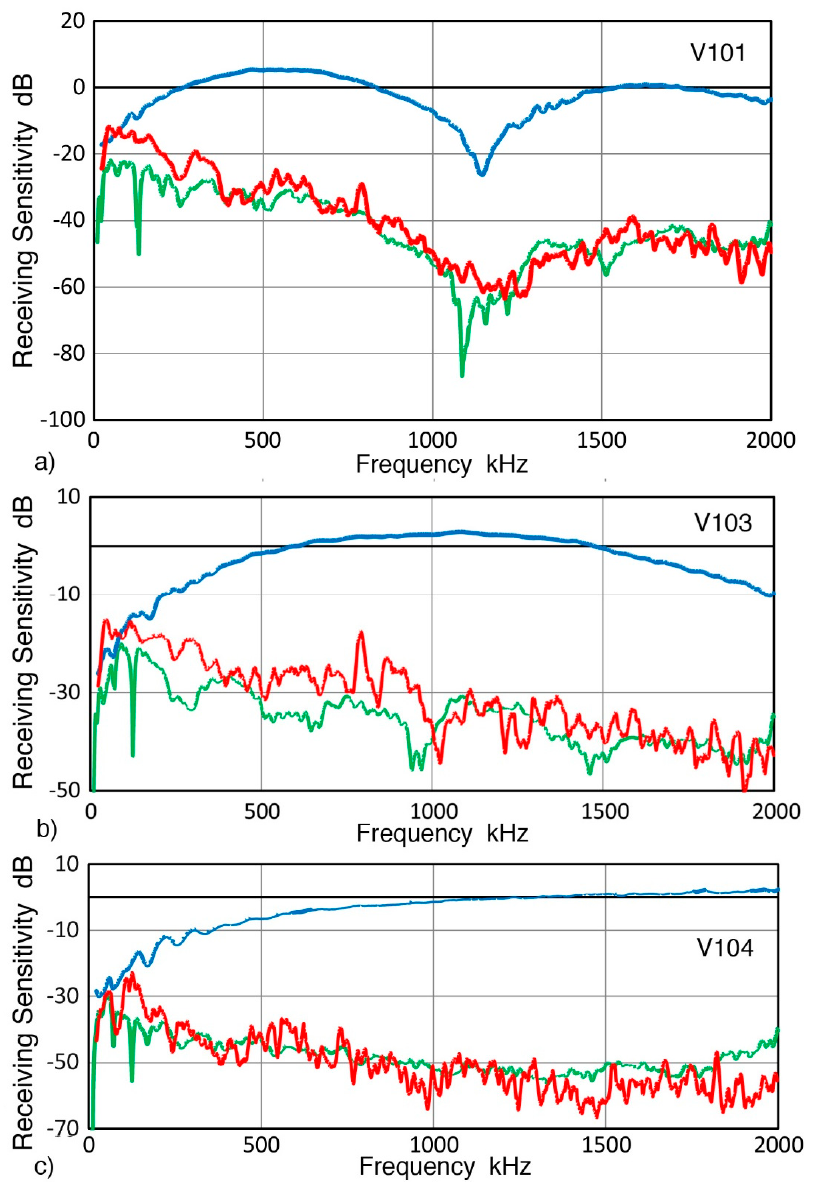
Figure A3. Receiving sensitivities of three ultrasonic transducers to three wave modes, NW (blue curves), RW (green curves), and GW (red curves). ( a ) Olympus V101 transducer, ( b ) V103 transducer, and ( c ) V104 transducer.